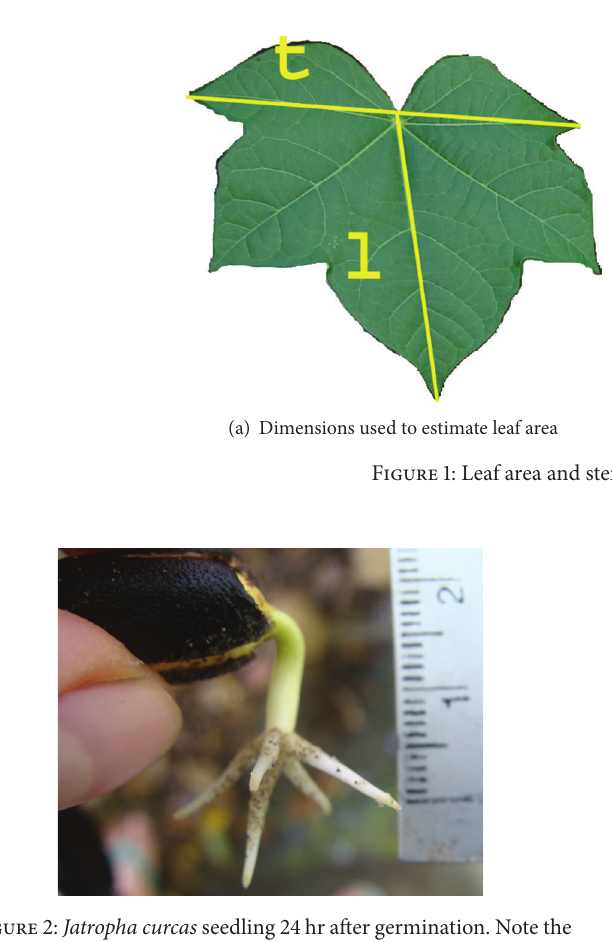
Figure 2: Jatropha curcas seedling 24 hr after germination. Note the radicle and four lateral roots which comprise its fundamental root